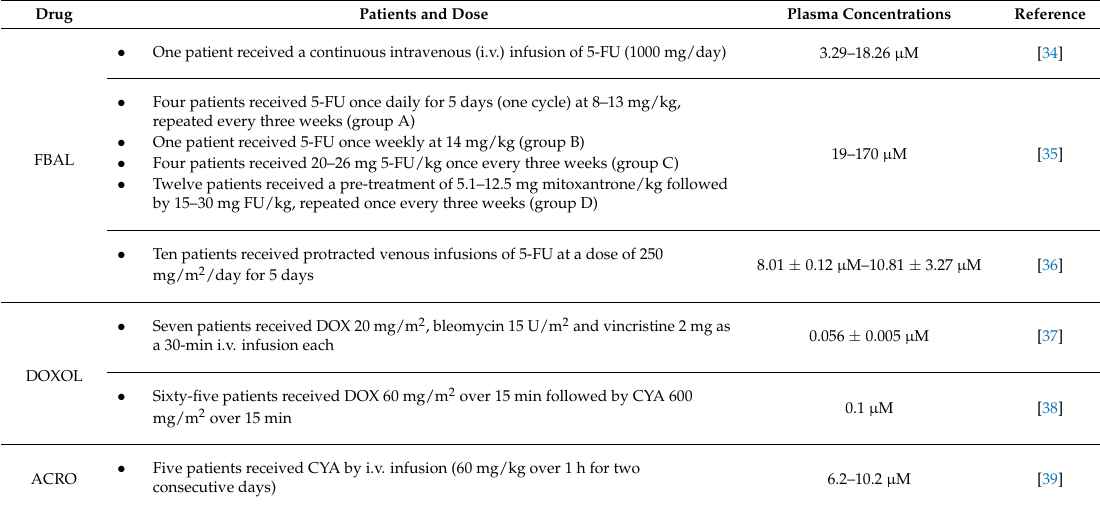
Figure 1. The 5-fluorouracil (5-FU) anabolism and catabolism pathways [30–32]. Table 1. Plasma concentrations of α -fluoro- β -alanine (FBAL), doxorubicinol (DOXOL), or acrolein (ACRO) in chemotherapy-treated patients.